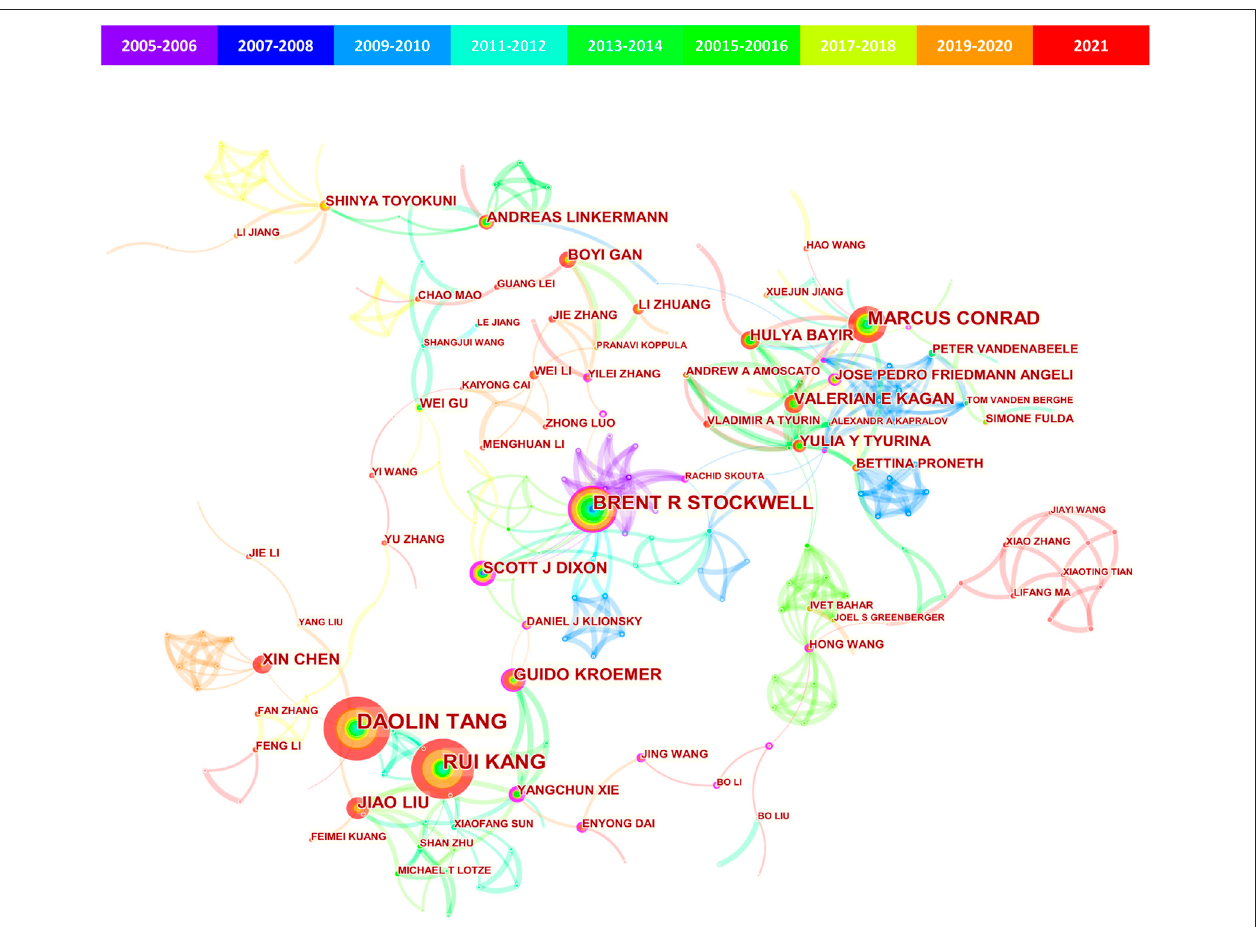
FIGURE 3 | CiteSpace visualization map of authors involved in ferroptosis in cancer. The nodes represent authors (the larger circle, the higher the number of publications); lines between the nodes represented a collaboration between two authors on the same article (the wider lines, the more frequency of collaborations); the colors in the nodes represented the years, and the purple ring represented high centrality ( ≥ 0.10).